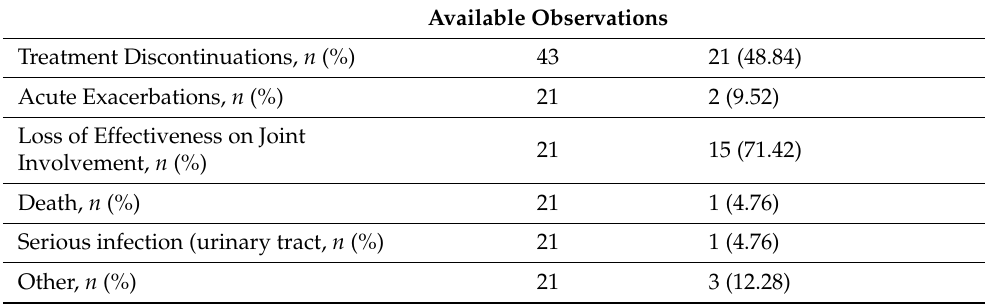
Table 3. Causes of treatment discontinuation and adverse